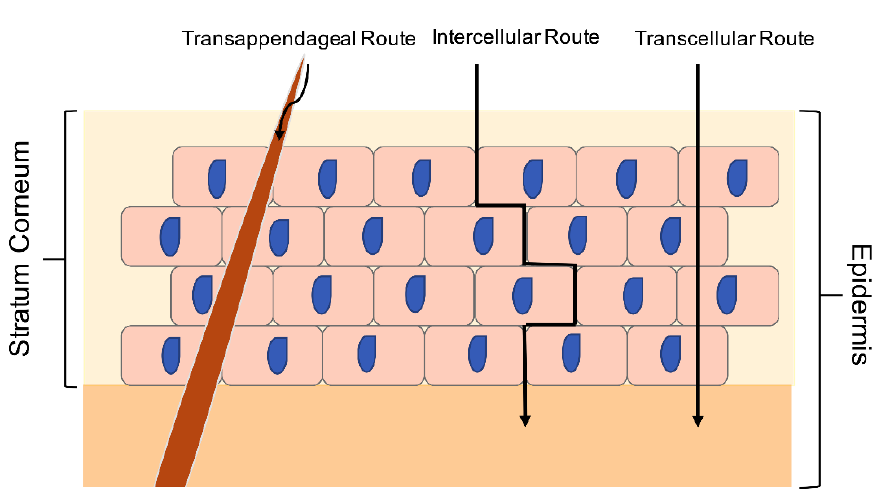
Figure 2. Mechanism of transdermal drug delivery.